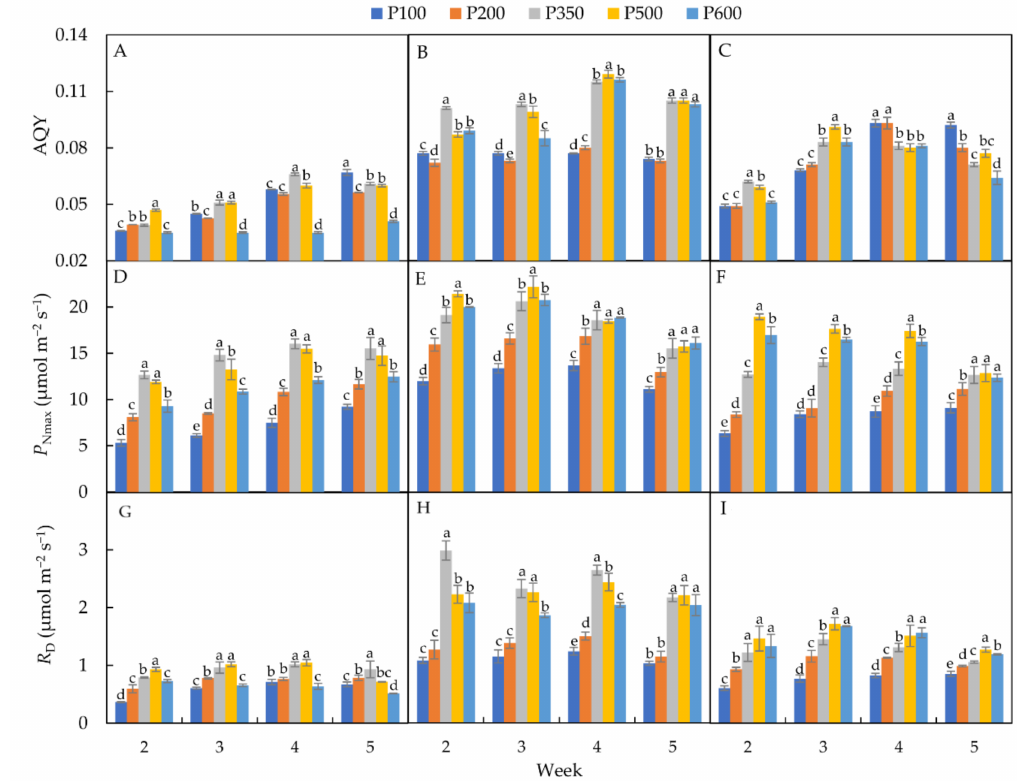
Figure 2. Apparent quantum efficiency (AQY) ( A – C ), maximum photosynthetic rate ( P Nmax ) ( D – F ), dark respiration rate ( R D ) ( G – I ) under different temperature and light conditions. Mean values with standard error of mean ( n = 3). Left side ( A , D , G ), middle ( B , E , H ), and right side ( C , F , I ) represented T15, T23, and T30, respectively. Letters indicate significant differences at p < 0.05 according to the LSD